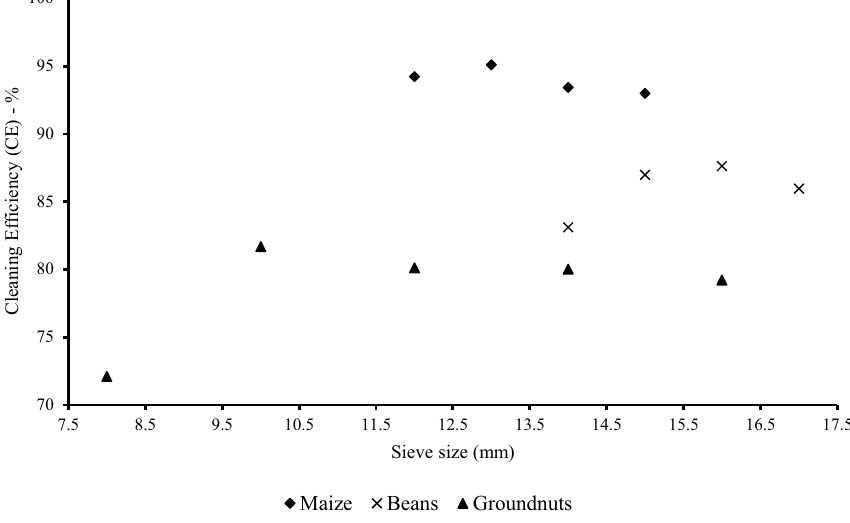
Fig. 5 A plot of cleaning effi- ciency against sieve